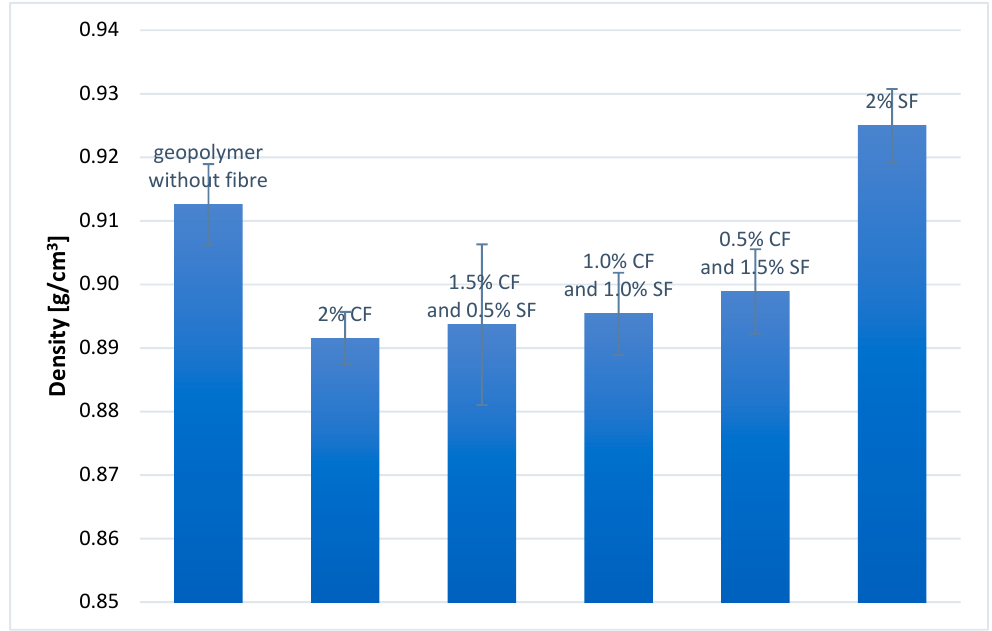
Figure 6. Density of geopolymer composites without/with fibers.